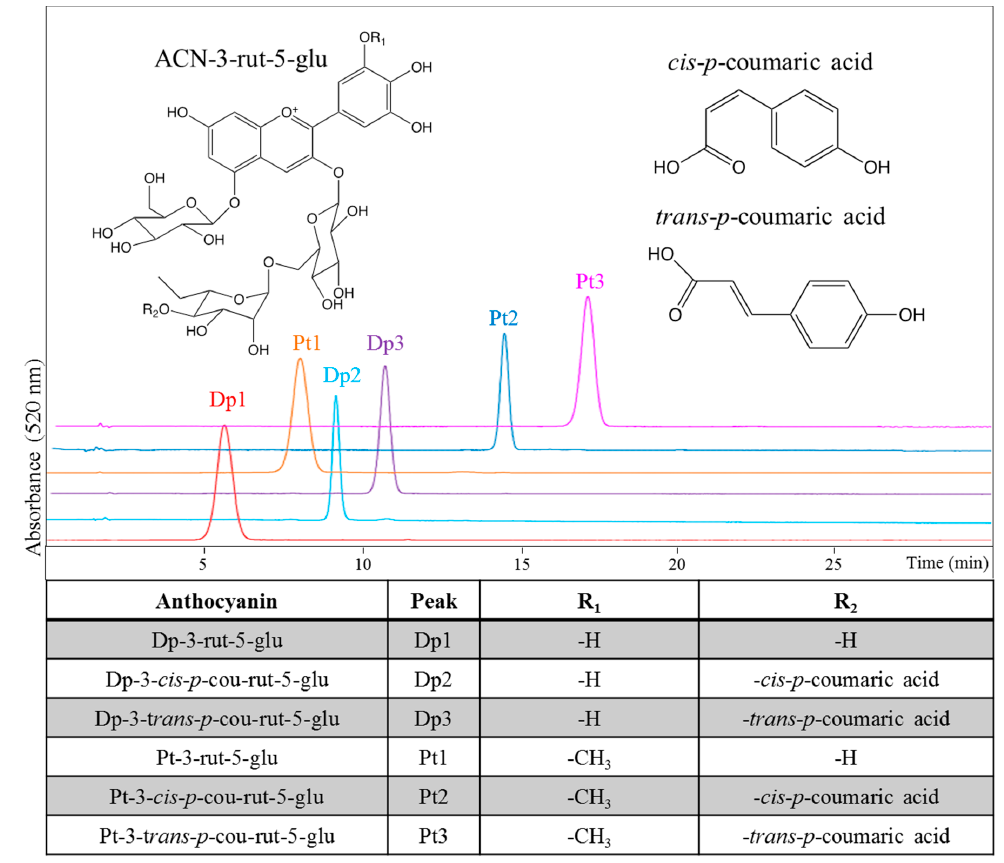
Figure 1. HPLC chromatograms (detection at 520 nm), identities, and structures of isolated delphinidin (Dp) and petunidin (Pt) derivatives.